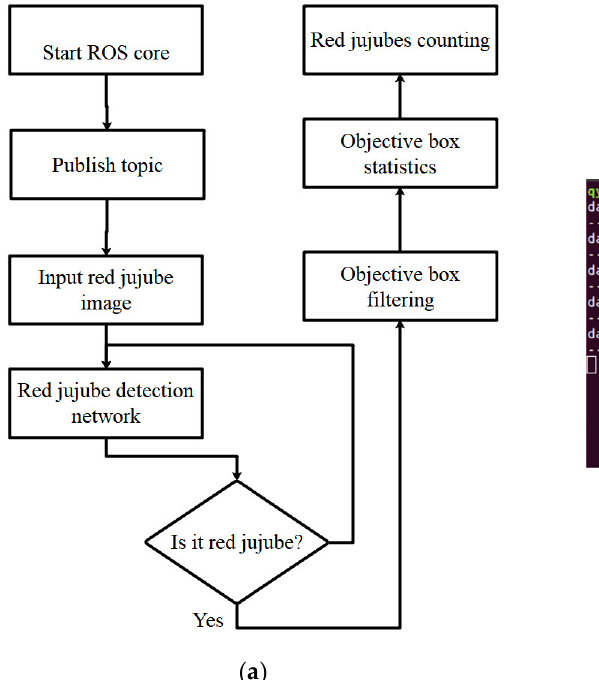
Figure 10. Counting method of red jujube. ( a ) the process of the red jujube counting method; ( b ) the results of the jujube counting method.